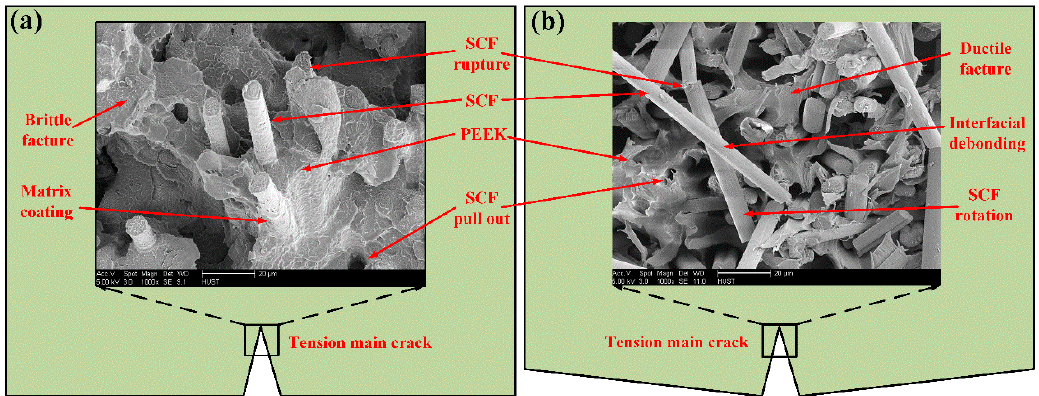
Figure 10. SEM of SCFR/PEEK composites depicting the flexural fracture mechanisms with the process zone ahead of the main tension crack at room temperature and high temperature: ( a ) room temperature, ( b ) high temperature, above T g .